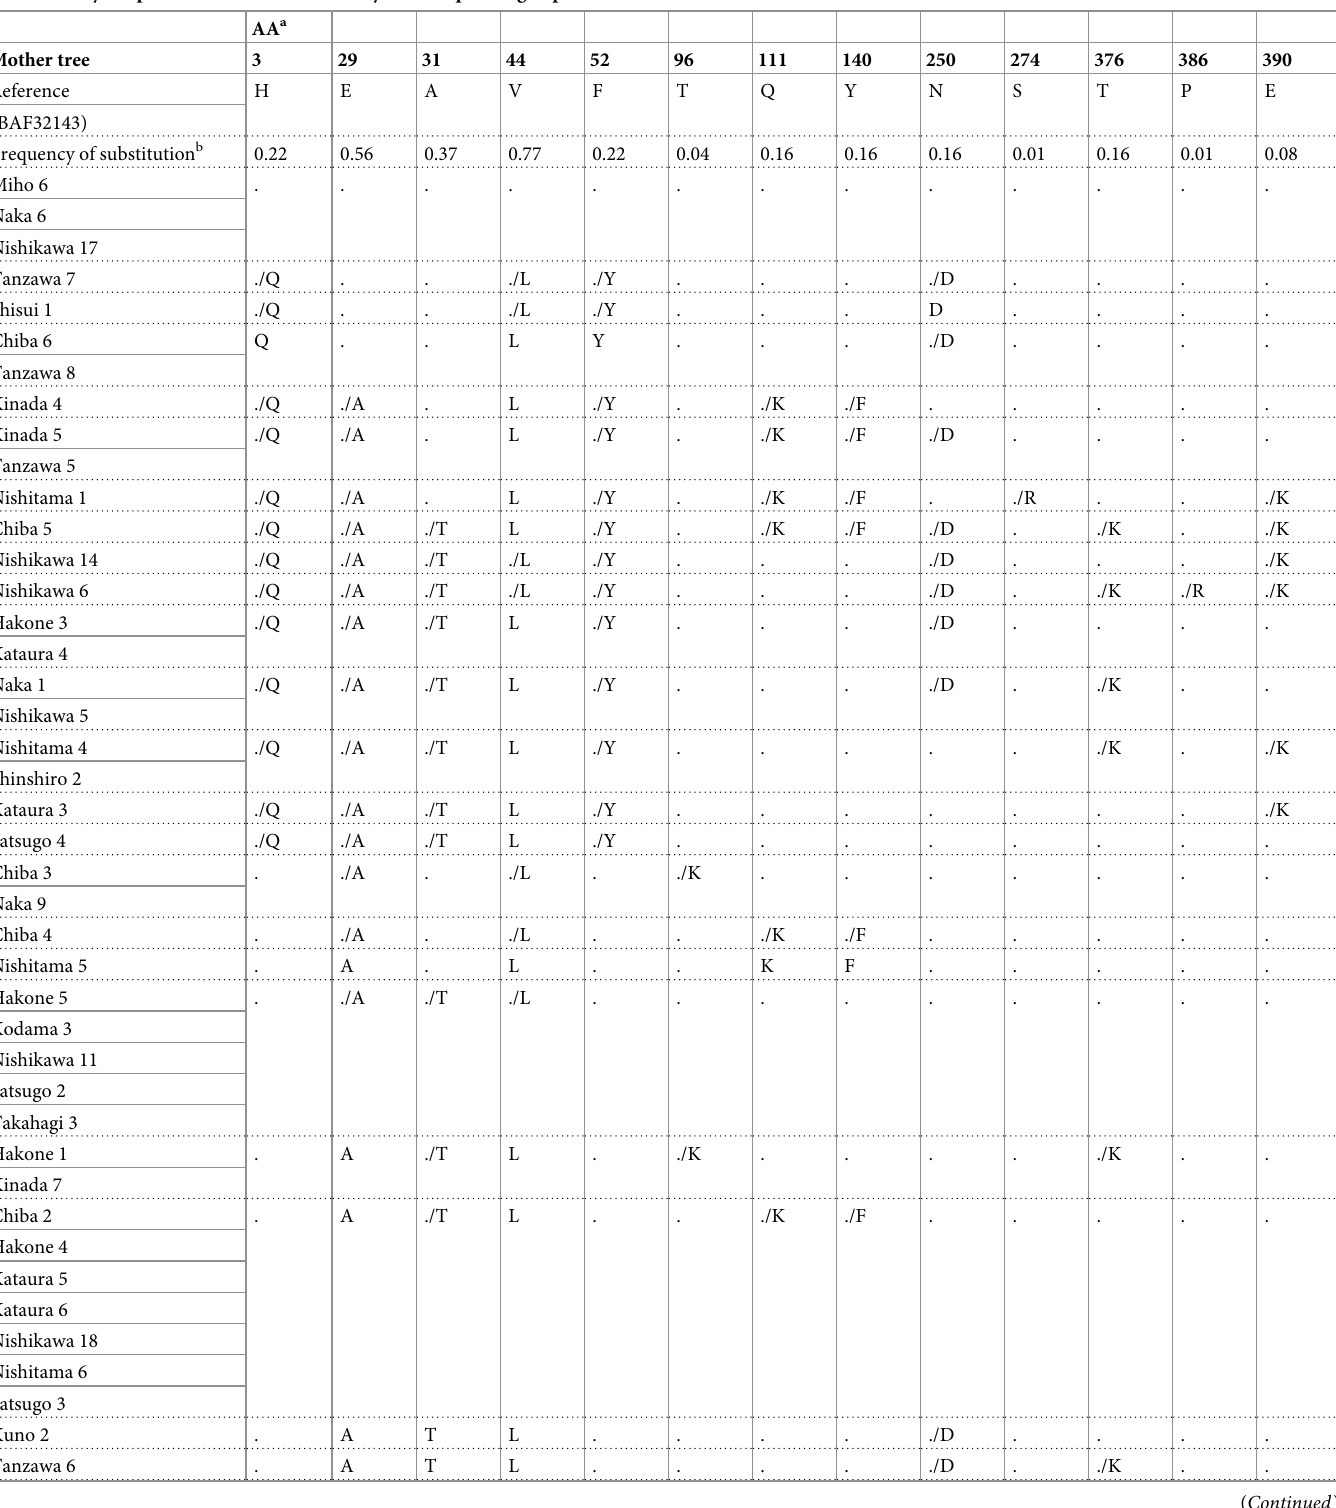
./Q Shisui 1 ./Q Chiba 6 Tanzawa 8 Kinada 4 ./Q ./A . ./Y ./K ./F Kinada 5 ./Q ./A . L ./Y . ./K ./F ./D . . . . Tanzawa 5 Nishitama 1 ./Q ./A . L ./Y . ./K ./F . ./R . . ./K Chiba 5 ./Q ./A ./T L ./Y . ./K ./F ./D . ./K . ./K Nishikawa 14 ./Q ./A ./T ./L ./Y . ./D . ./K Nishikawa 6 ./Q ./A